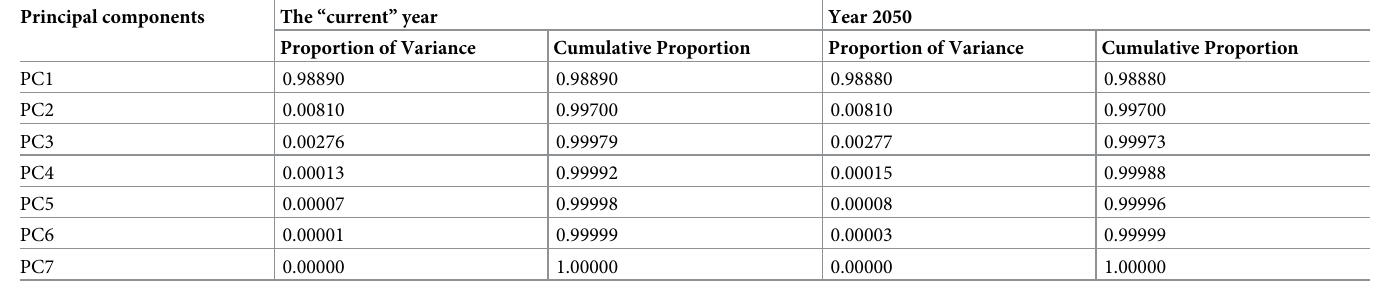
Table 1. Representation of the first seven principal components derived from all 24 original environmental variables along with the proportion of variance in envi- ronmental variables explained by each principal component and their cumulative proportion of variance. Principal